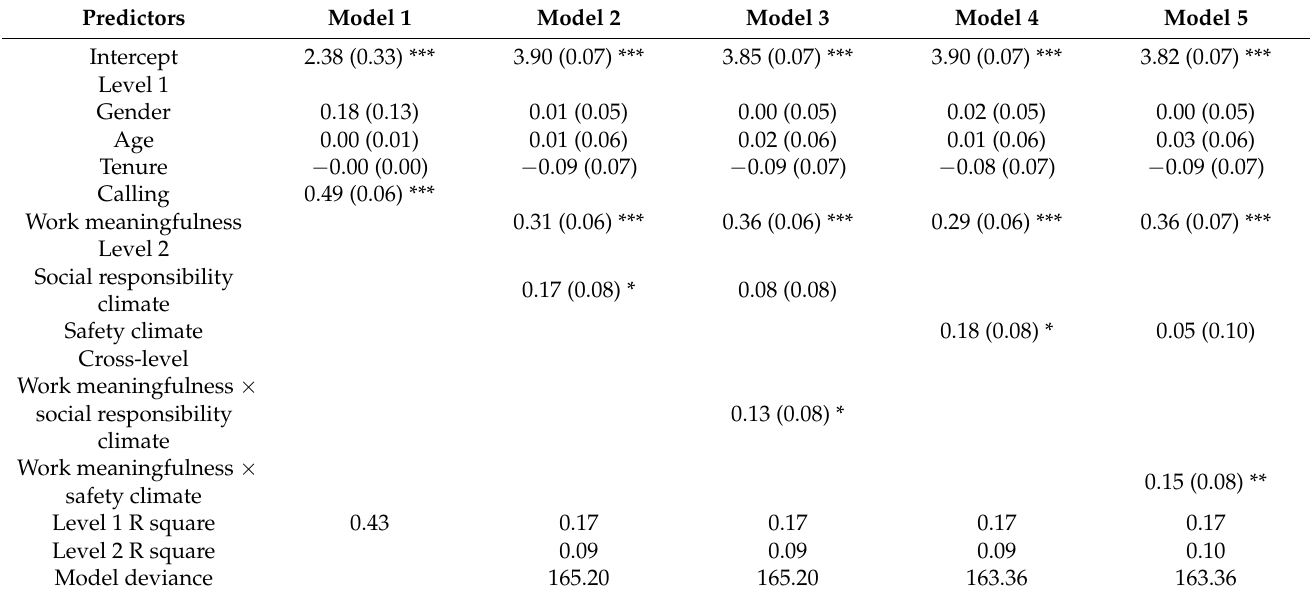
Table 3. Hierarchical linear modeling results: the effects of work meaningfulness, social responsibility climate, and safety climate on work